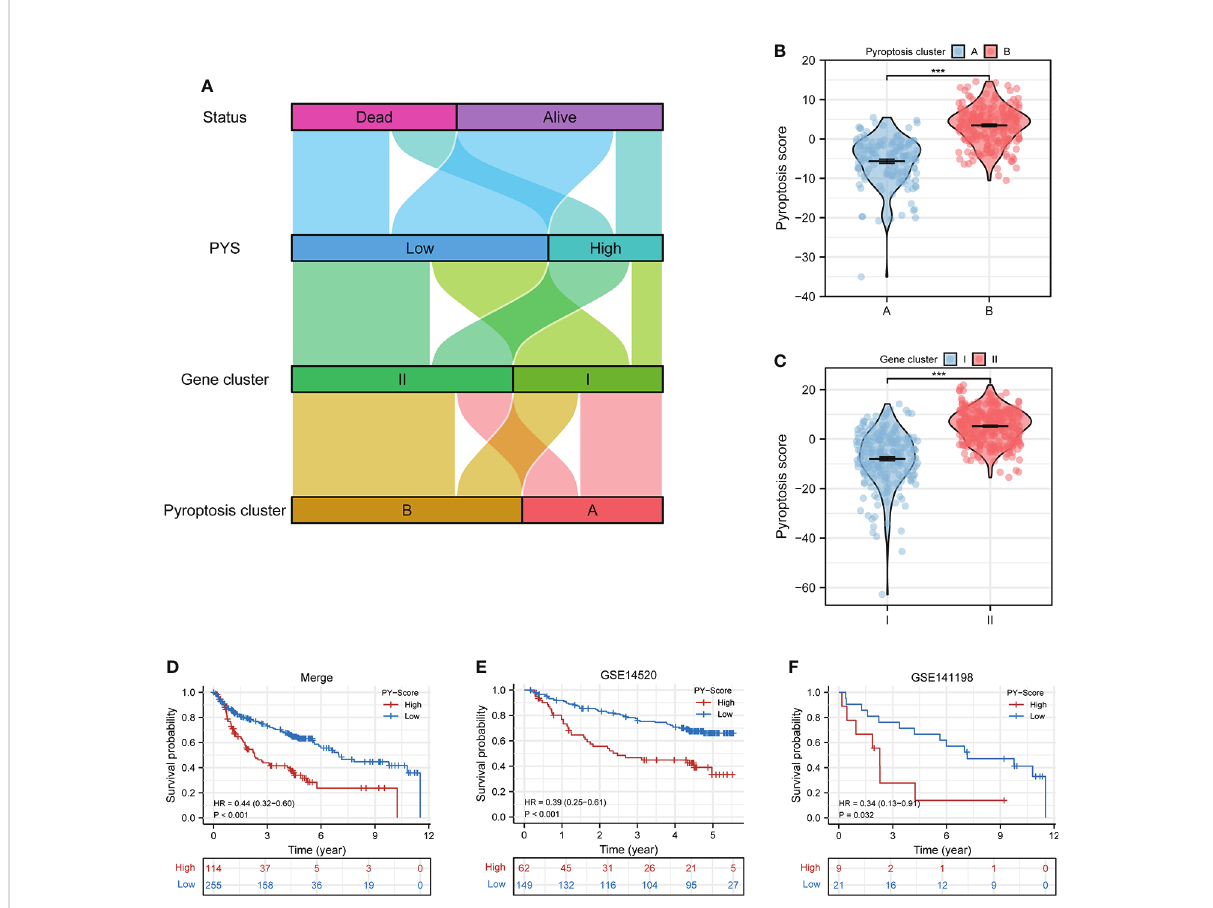
FIGURE 4 Construction of the PYS model for HBV-HCC patients. (A) Crosstalk between pyroptosis clusters, gene clusters, pyroptosis score, and survival status. (B, C) The differences in pyroptosis score in the pyroptosis clusters (B) and the gene clusters (C) . (D – F) Kaplan-Meier curves of patients within PYS groups in merge cohort (D) , GSE14520 (E) , and GSE141198 (F) . PY, pyroptosis score. ***P <